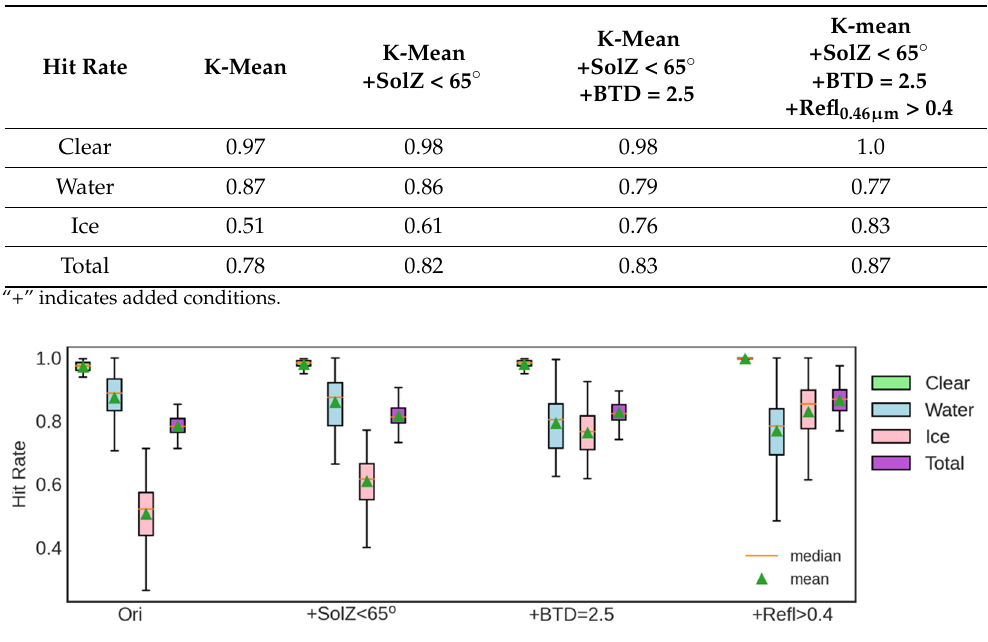
Figure 7. Boxplot of FY-4A cloud top phase hit rate validated against CALIPSO VFM.